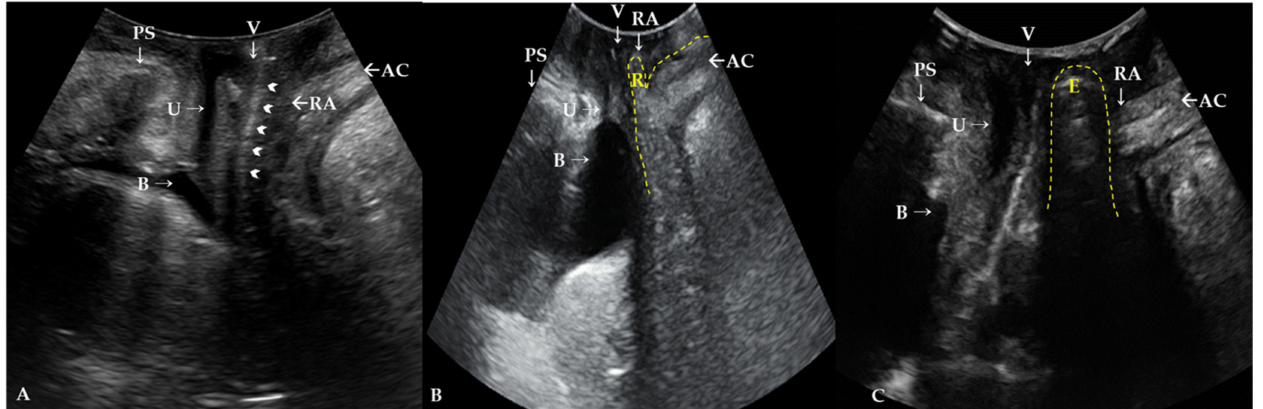
Figure 2. Translabial ultrasonography ( A ) in resting phase. Rectovaginal septum (arrowheads). AC, anal canal; B, bladder; PS, pubis symphysis; RA, rectal ampulla; U, urethra; V, vagina. Translabial ultrasonography in patients with ( B ) rectocele and ( C ) enterocele in maximal Valsalva phase. Rectocele filled with stool and air, resulting in hyperechogenicity, and the defect of the rectovaginal septum is observed in the maximal Valsalva maneuver ( B ). The contents of an enterocele appear generally iso- to hyperechogenic compared with a rectocele and bowel peristalsis is usually observed in the enterocele sac ( C ). R, rectocele; E,